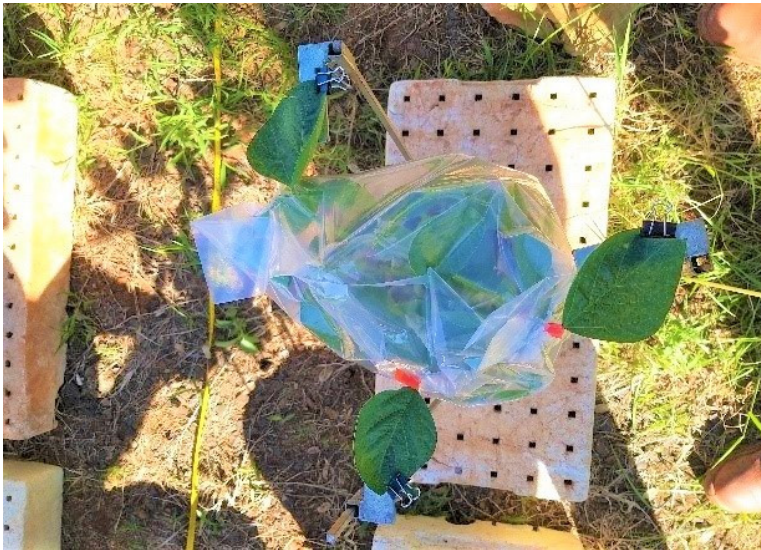
Figure 1. Detail of plant exposure to spraying.